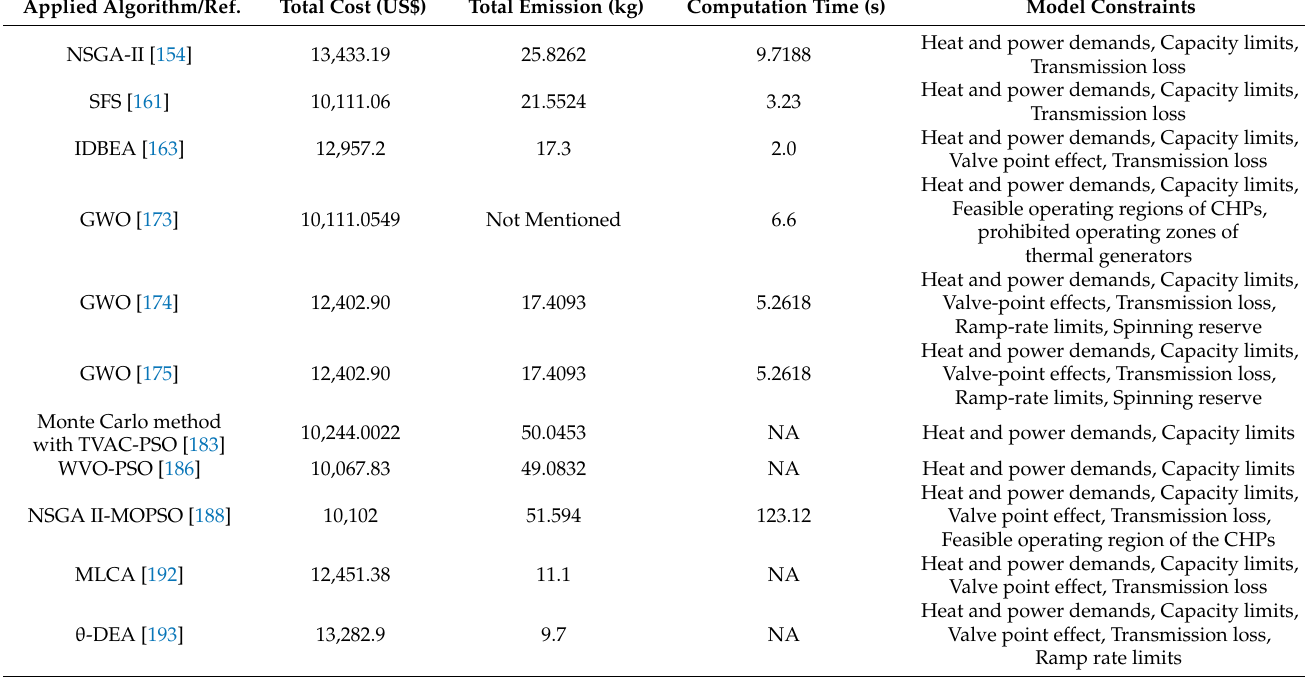
Figure 13. Sharing of the multi-objective CHP optimization issues per four categories. Table 11. The numerical results of implementing different algorithms in a CHPEED optimization model *.